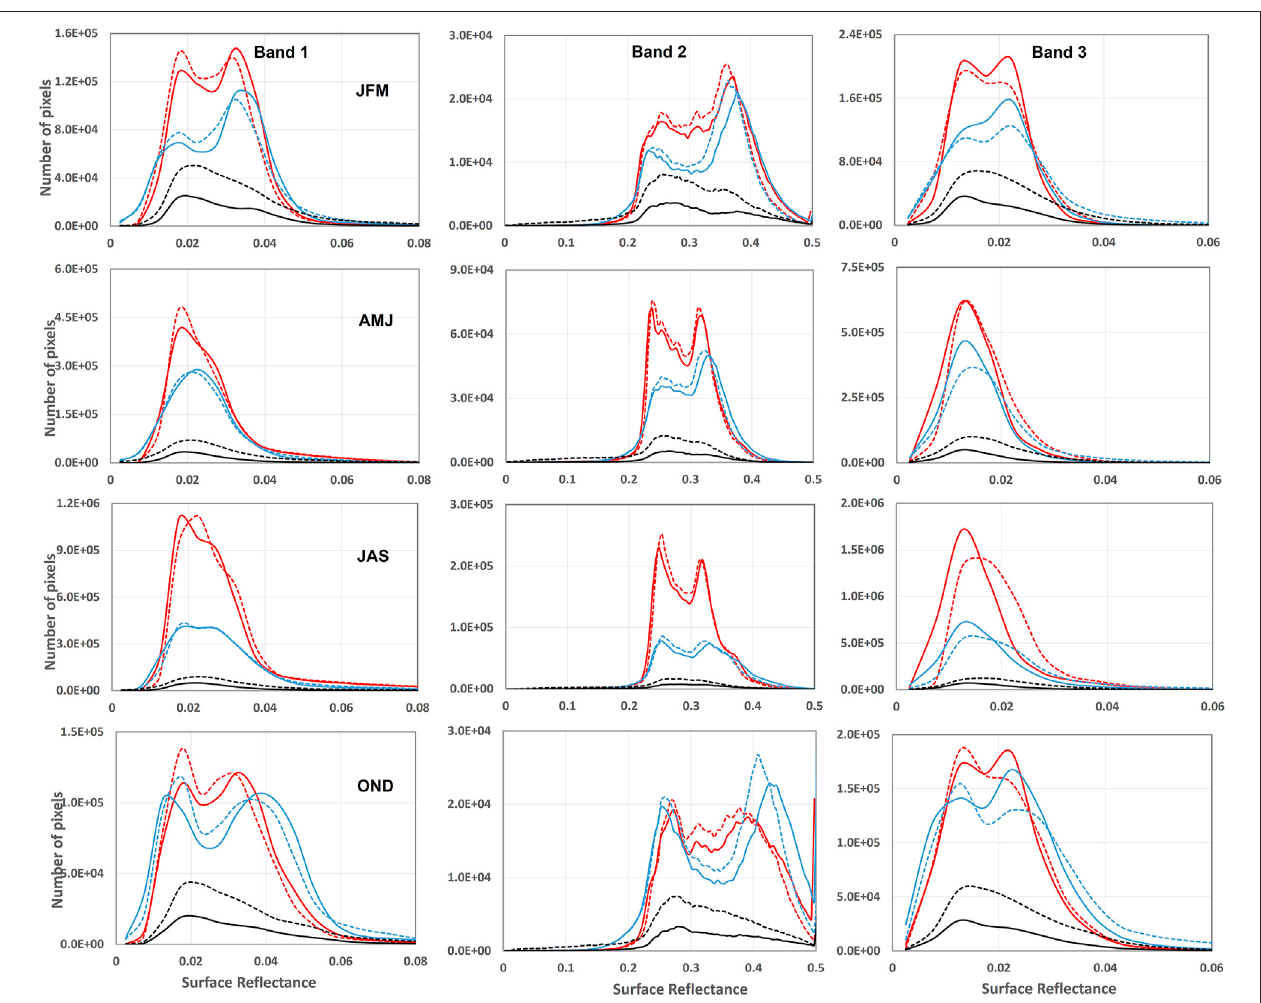
FIGURE 5 | Quarterly distributions (rows) of MCD19A1 and MOD09 surface re fl ectance in bands 1 – 3 (columns) from high quality pixels over Amazon tile H11V09 for2018.Thepixels aregroupedinthreecategoriesaccordingtotheirquality: (A) “ high ” inboth algorithms(Red lines); (B) “ high ” inMCD19A1and “ low ” inMOD09(Blue lines); (C) “ high ” in MOD09 (Black line) and “ low ” in MCD19A1. The solid and dashed lines represent the MCD19A1 and MOD09 SR, respectively.